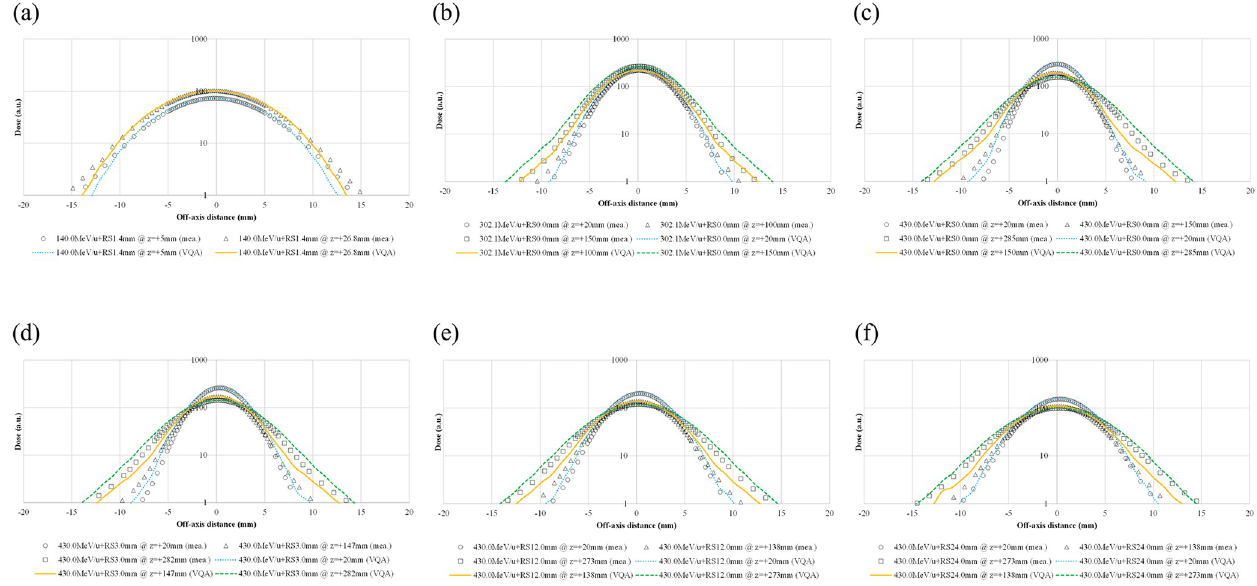
Fig 4. Lateral-dose profiles in water at selected energies and different positions. The profiles are for pencil beams with energies of 140.0, 302.1, and 430.0 MeV/u (a–c, respectively). Pencil-beam profiles at an energy of 430.0 MeV/u for cases with RS thicknesses of 3.0, 12.0, and 24.0 mm (d–f, respectively).